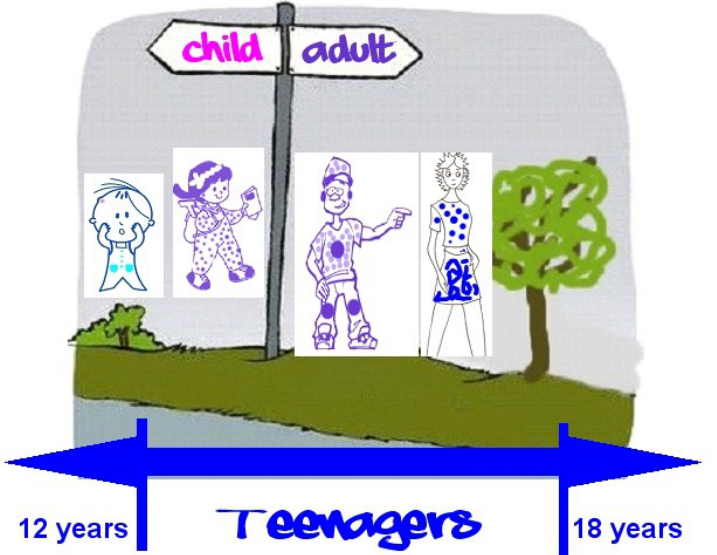
Figure 1. Teenagers and age